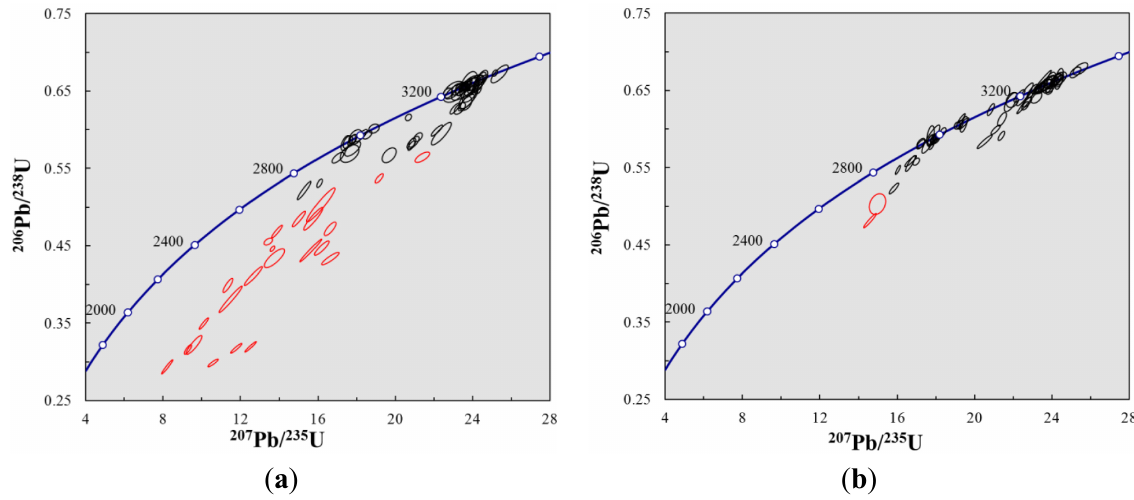
Figure 5. U–Pb Concordia diagrams for sample TSUPB021: ( a ) Non-treated zircons; and ( b ) chemically abraded zircons. Data- point error ellipses are 2σ. Red ellipses : analyses > 10% discordant. Black ellipses: analyses < 10% discordant.